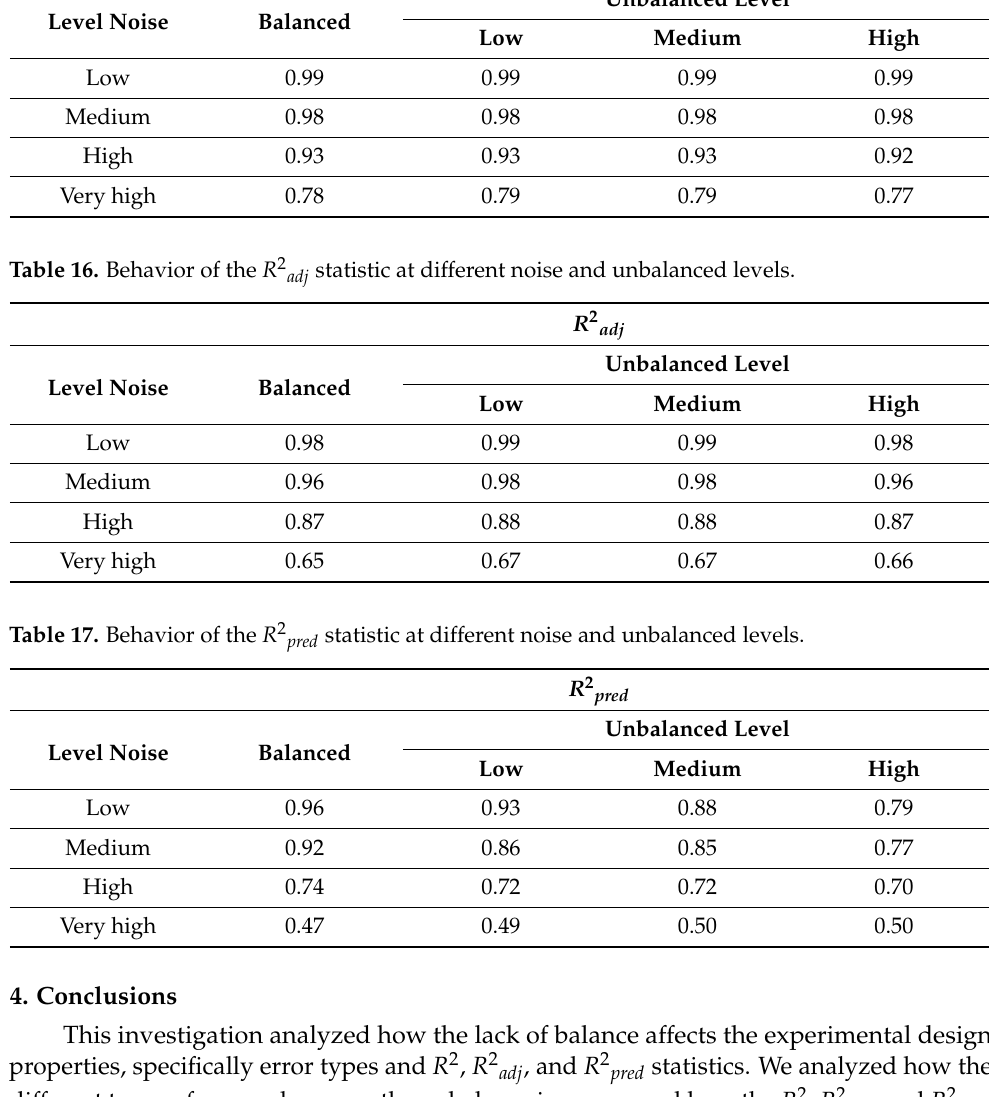
Table 15. Behavior of the R 2 statistic at different noise and unbalanced levels.